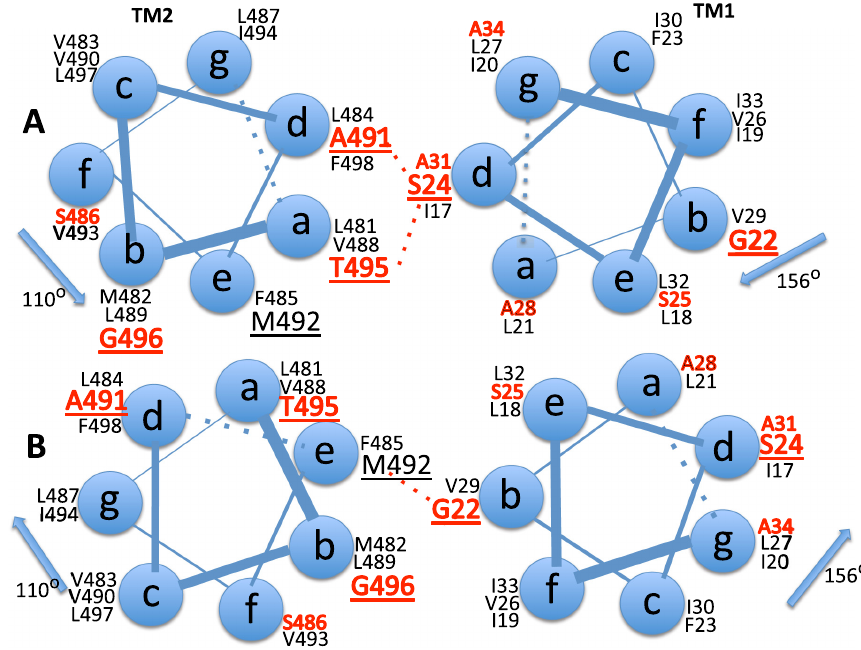
Figure 6 . Helical wheel heptad projections (45) of TM1 and TM2 showing the arrangement of the amino acids on the surface of the helix. TM1, starting with A34, and TM2, starting with L481, are shown from the extracellular surface to the cytoplasmic surface of the membrane going into the plane of the page. The residues colored red have helix packing values larger than that of Gln (38). The sur- faces of TM1 with G22 and S24 are proposed to interact with the surfaces of TM2 with G496/M492 and T495/A491, respectively. (A) TM domain interactions in the open state and (B) TM domain interactions in the closed state. The arrows indicate the direction of rota- tion of the TM domains through the stated angles in order for the TM domains to move from one stable interaction to the